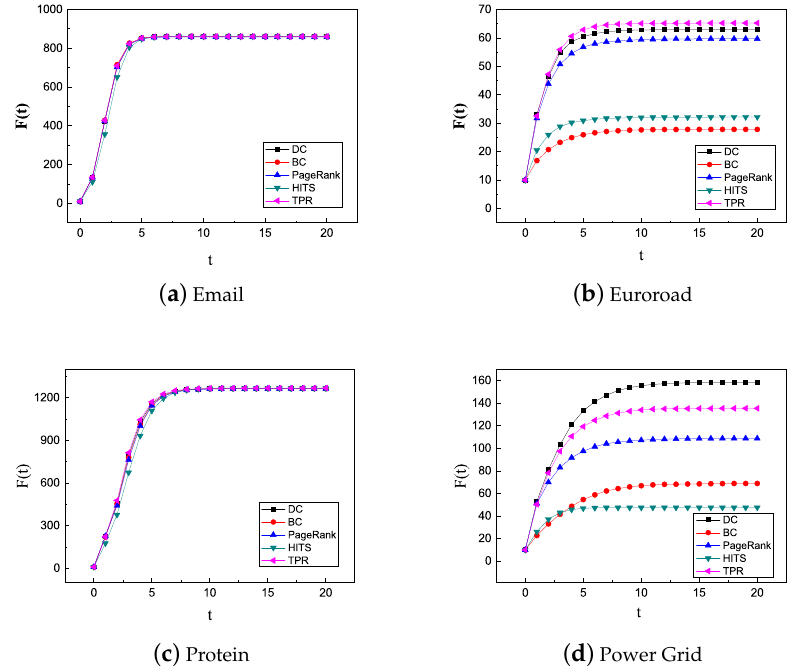
Figure 7. Growth of infected and recovered nodes for different